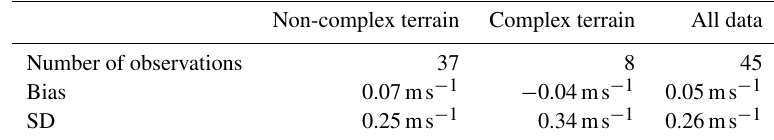
Table 2. Validation statistics for the assessment of ME-WAM with MTLA applied for a sample of 45 data points.